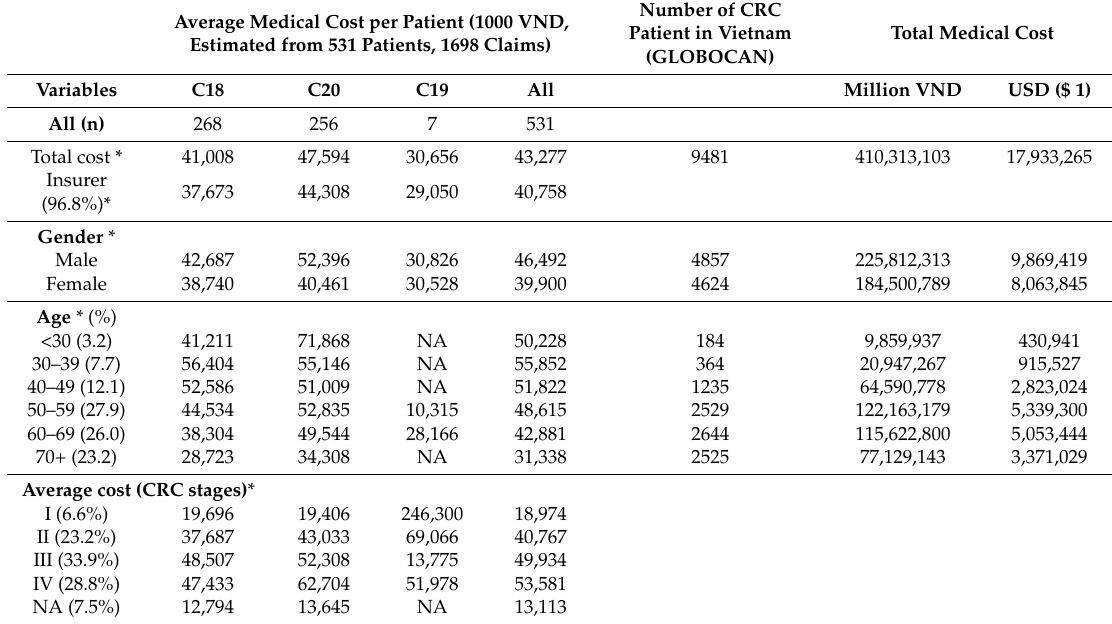
Table 1. Average Medical Cost of Colorectal Cancer per Patient and Estimated Total Medical Cost at National Level in Vietnam,